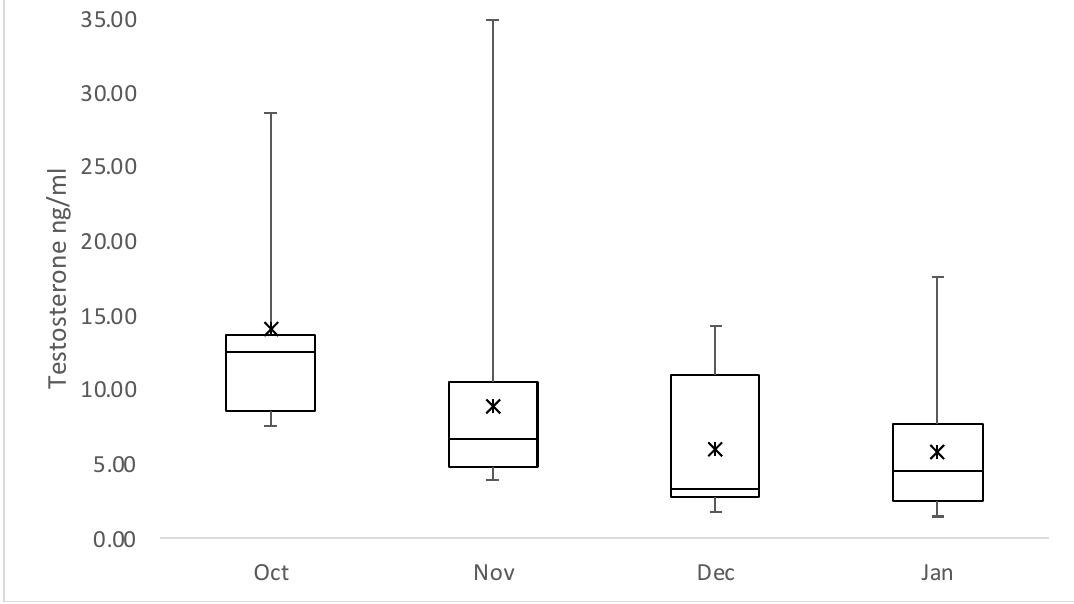
Figure 1. Comparison of testosterone concentrations in ng/mL between months in postpubertal wild boar males. At the beginning of the mating season in October (Oct), T values were significantly higher than in December (Dec) and/or January (Jan). Nov = November.